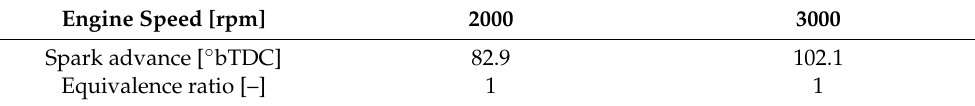
Table 3. Test cases, WOT, no boost. Optimal spark timing.